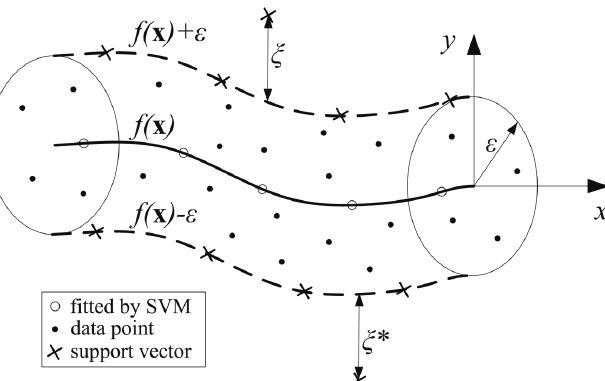
Fig. 2 – Graphical representation of SVM 15